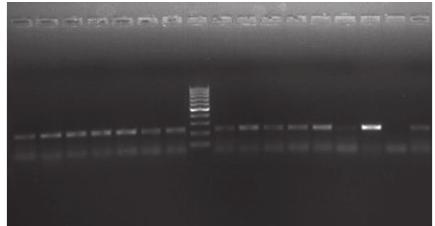
Figure 6: Gel electrophoresis analysis showing the presence of bro- 1 in all isolates